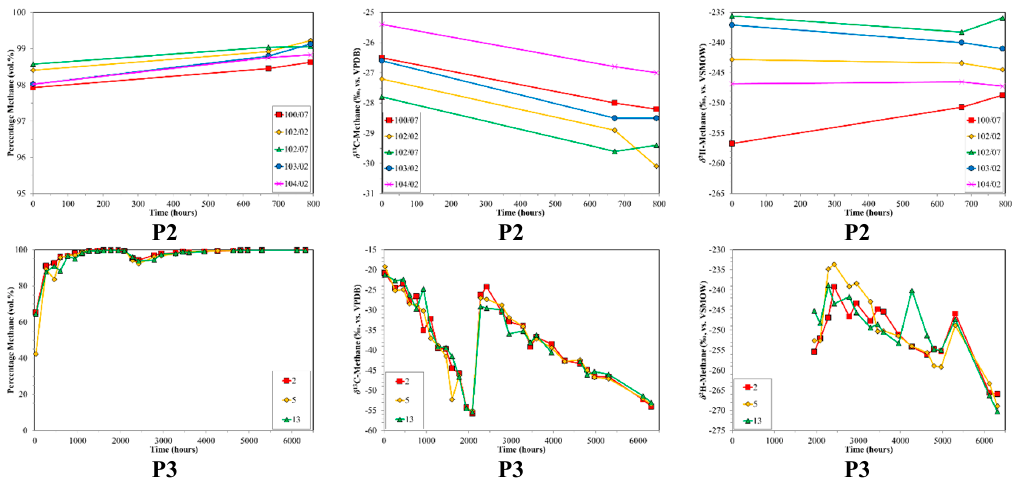
Figure 1. Time series of volume % methane, δ 13 C-CH 4 and δ 2 H-CH 4 for production sample sets P1, P2 and P3 versus production time. The 0 h value corresponds to the first samples collected. Note the different scales between production sample sets.